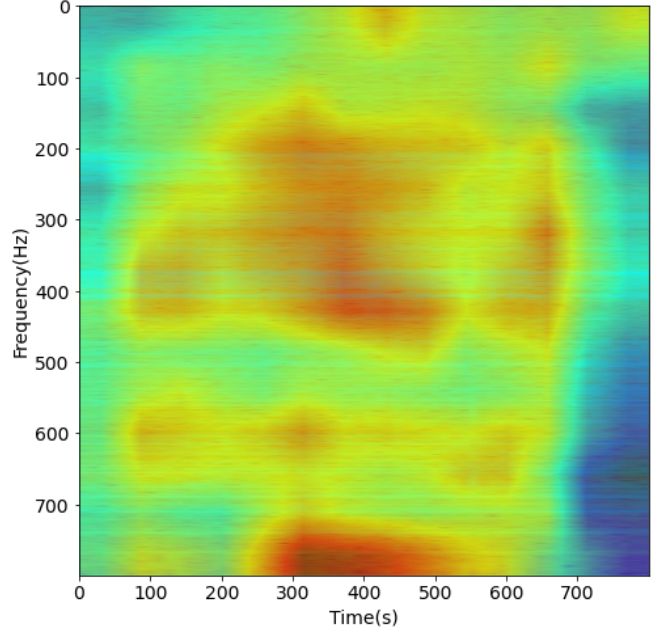
Figure 18. Proposed CNN Heatmap with spectrogram of Record 1.